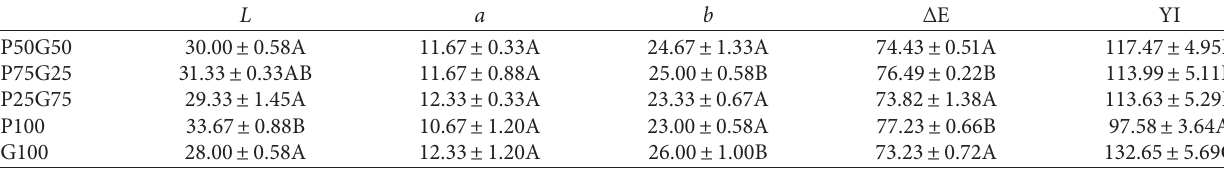
Table 3: The effects of pectin: gum ratio on the color properties of samples.